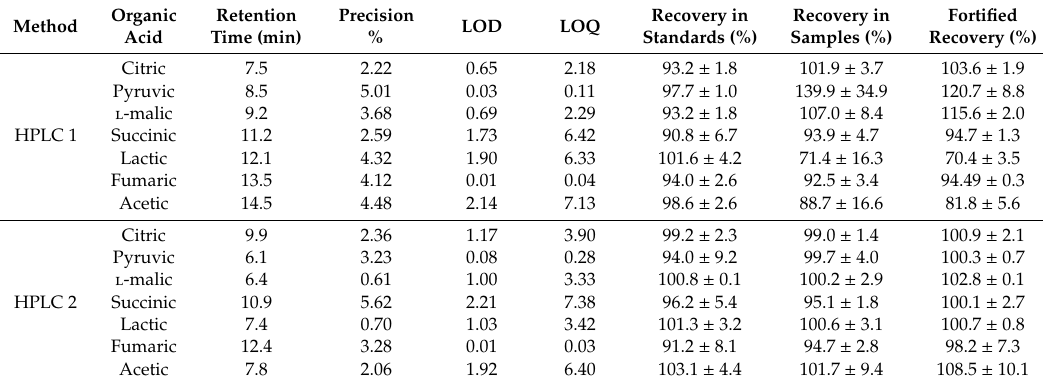
Table 4. Recovery of organic acids treated with LC-18 SPE tube.